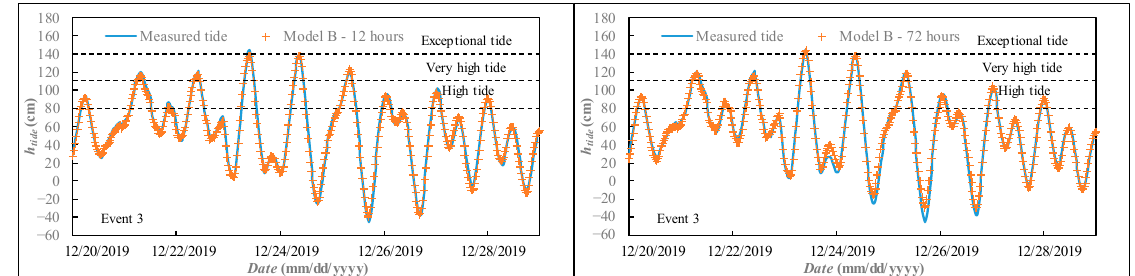
Figure 8. Event 3, extreme storm tide event forecasting for the period 20–29 December 2019, comparison between measured time series and predicted values: Model B, t a = 12 h (on the left ), t a = 72 h (on the right ).